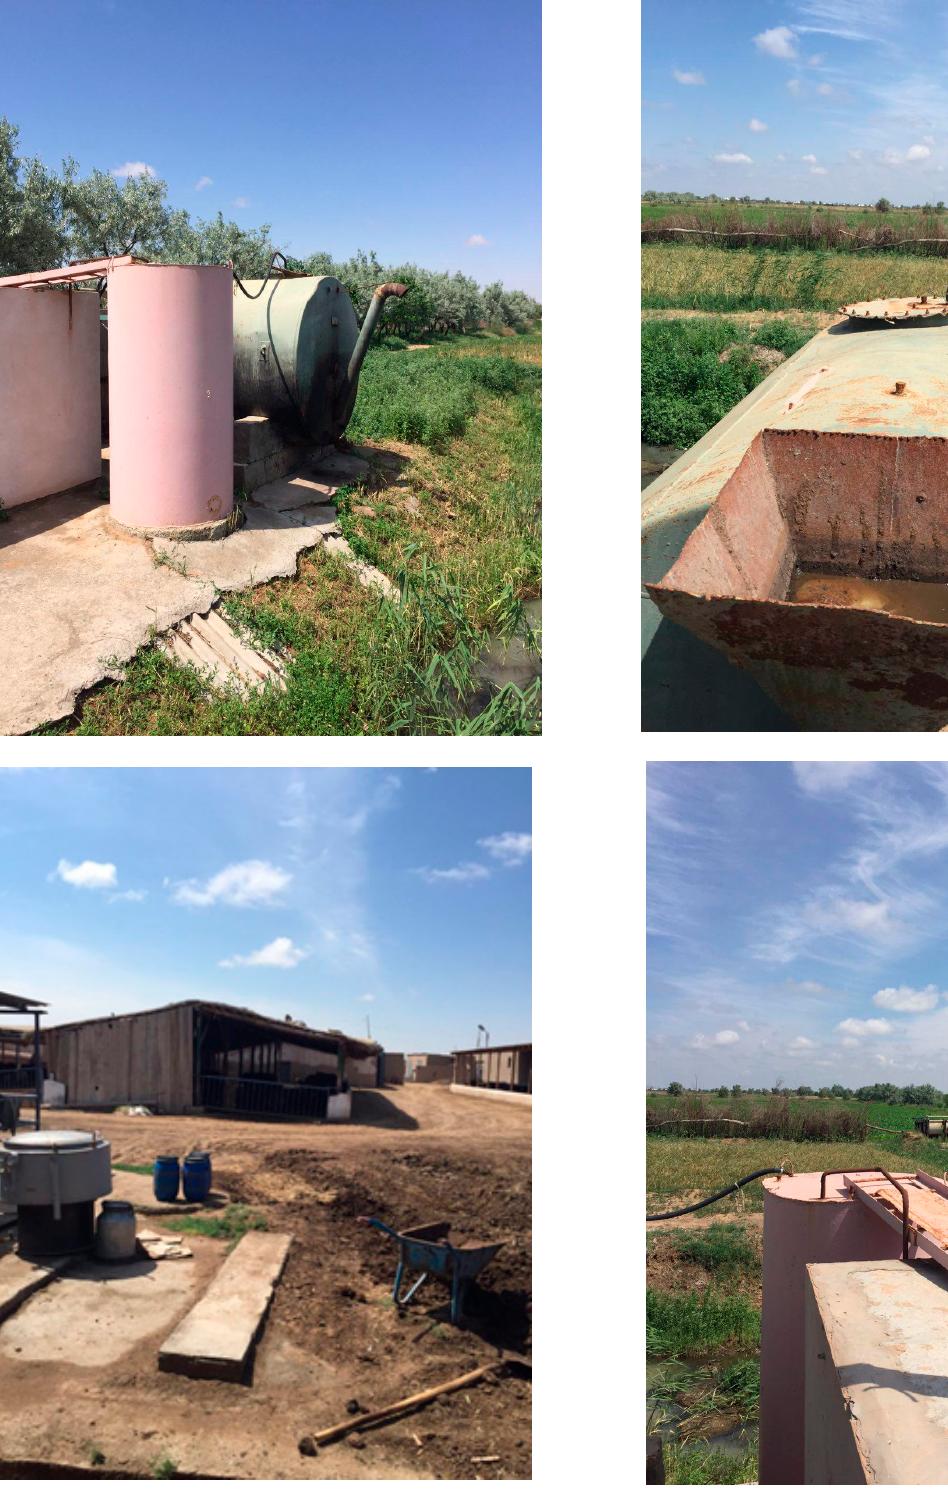
Figure 3. Biogas plant at Yuldosh Majid farm.